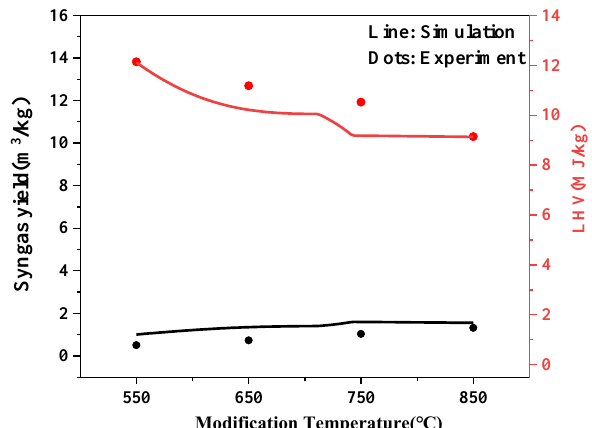
Figure 15. Effect of the modification temperature on the gas distribution and mass flow for CaCO 3 generated in the modified reactor.